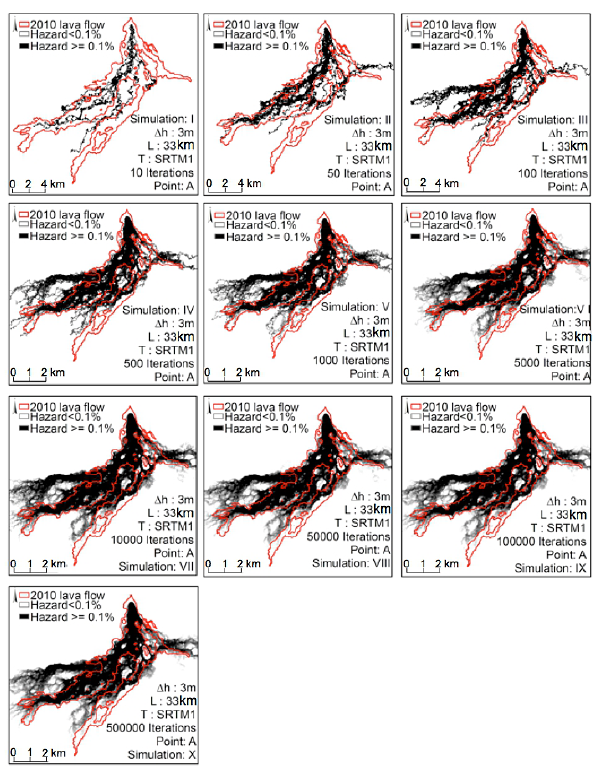
Figure 4. Simulations considering 10, 50, 100, 500, 1000, 5000, 10000, 50000, 100000, and 500000 iterations. 5. “Outside true pixels”: number of pixels of the DEM cor- responding to probable pixels that do not coincide with true pixels; 6. “Length parameter”: value of the input parameter “length” introduced into the model for the simulation; 7. “Modelled likely length”: maximum longitudinal length of the simulated lava